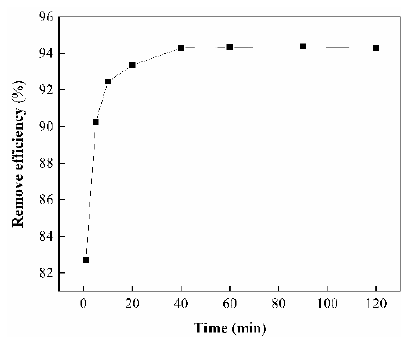
Figure 11. Effect of contact time on the As( Ⅴ ) removal.